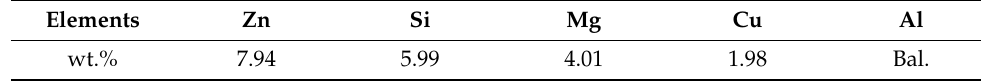
Table 3. Chemical composition of GHS.